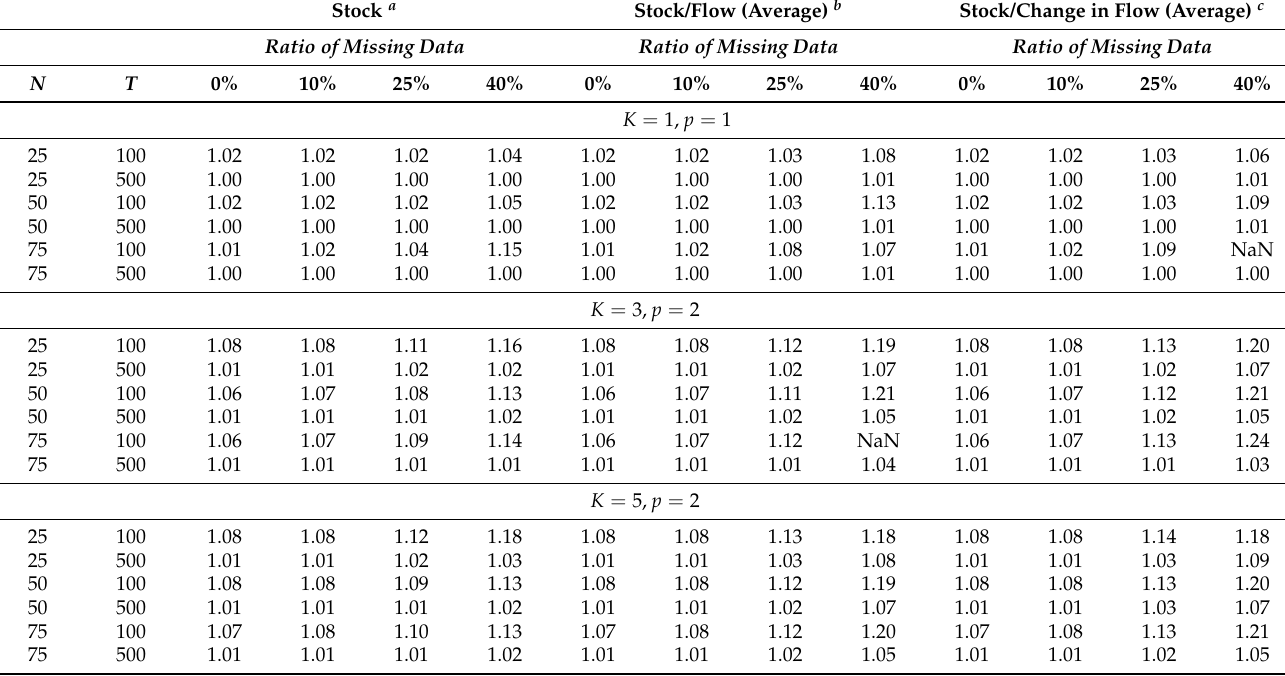
Table A3. Ratios of trace R 2 means for random ADFMs using both approaches. Stock a Stock/Flow (Average) b Stock/Change in Flow (Average) c Ratio of Missing Data